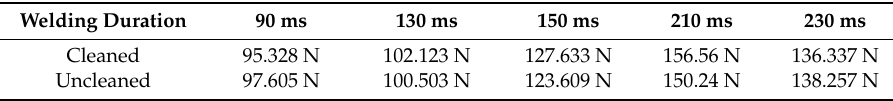
Table 1. Effects of surface preparations on the joint